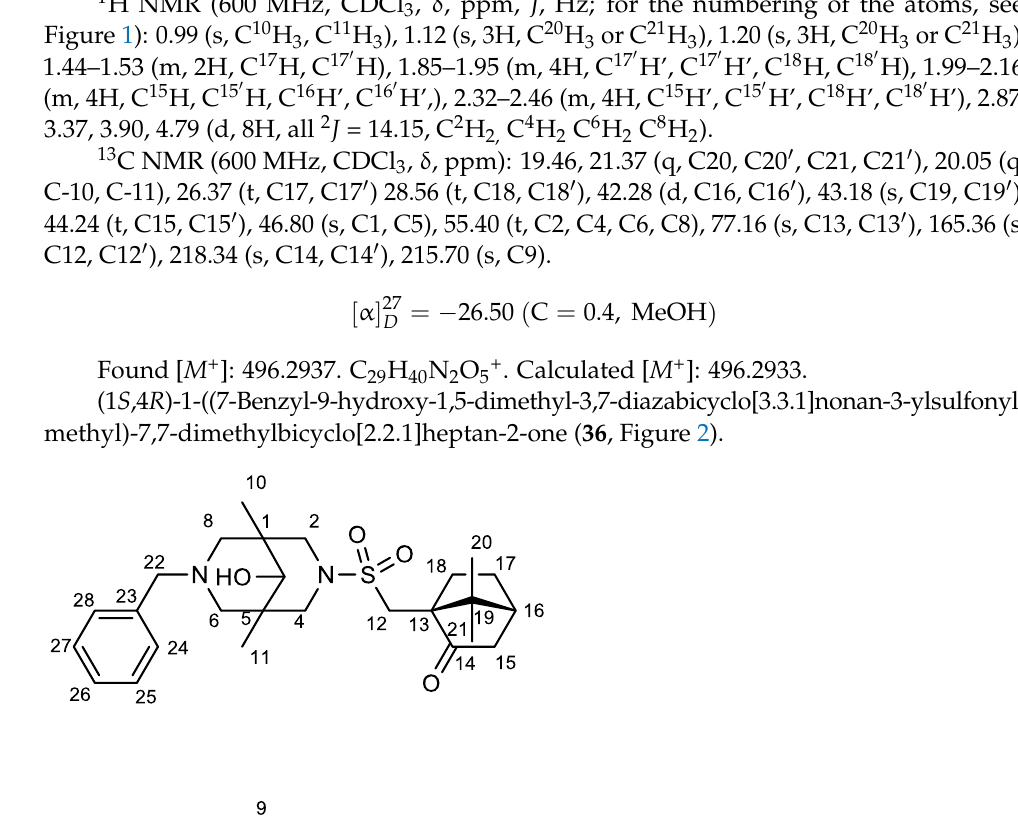
Figure 2. The structure of compound 36 with atom numbering scheme. To a solution of 100 mg (0.38 mmol) of bispidinol 25 in 10 mL of pyridine was added a solution of 106 mg (0.42 mmol) of acid chloride 32 in 5 mL pyridine dropwise. The mixture was refluxed for 2 h, pyridine was then evaporated. To the residue, 20 mL of diluted (4%) HCl solution was added and the mixture was stirred for 30 min, then it was extracted with diethyl ether (2 × 20 mL). The organic phase was dried over Na 2 SO 4 and then evaporated. The resulting mixture was purified by column chromatography on silica gel (3 g of silica gel, eluent n-C 6 H 14 /EtOAc). The desired product was isolated in an amount of 130 mg (yield 70%). 1 H NMR (600 MHz, CDCl δ , ppm, J , Hz; for the numbering of the atoms, see 3 , Figure 2): 0.86 (s, 3H, C 20 H 3 or C 21 H 3 ), 1.02 and 1.03 (s,6H, C 10 H 3 , C 11 H 3 ), 1.11 (s,